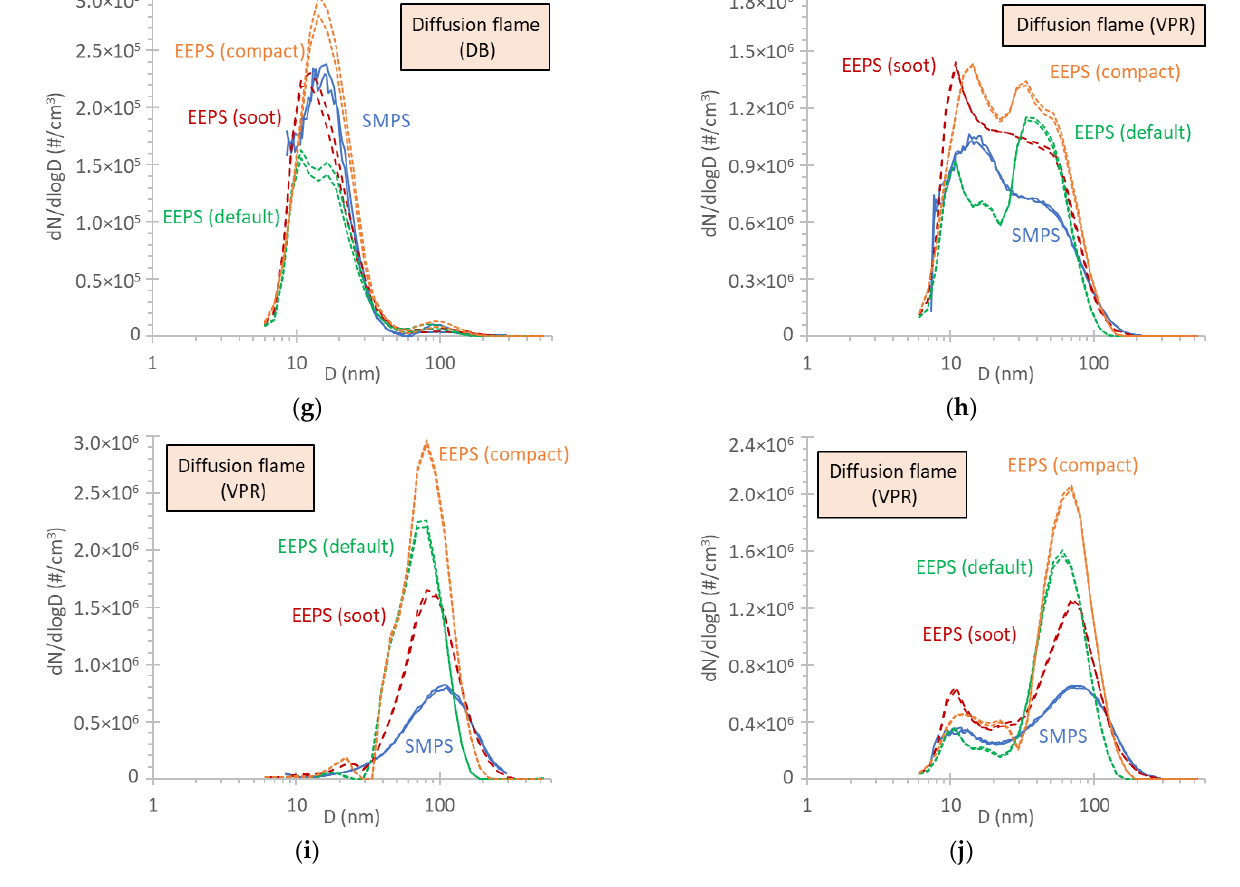
Figure A1. Size distributions measured with SMPS and EEPS applying the three matrices (“Default”, “Soot”, “Compact”): ( a ) GWG silver; ( b ) GWG silver; ( c ) SPG silver (oxidized); ( d ) salt (dried); ( e ) spark discharge graphite; ( f ) diffusion flame soot directly from the burner (setting 1); ( g ) diffusion flame soot directly from the VPR (setting 6); ( h ) diffusion flame soot directly from the VPR (setting 1); ( i ) diffusion flame soot directly from the VPR (setting 5); ( j ) diffusion flame soot directly from the VPR (setting 3). Settings can be found in Table 1.